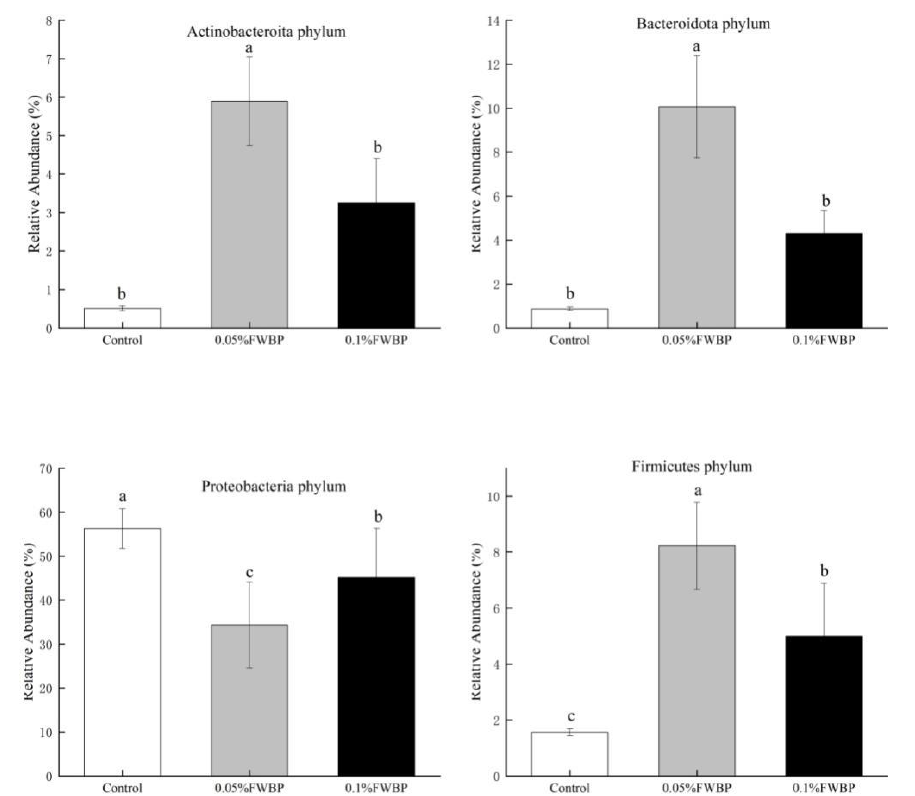
Figure 8. Microbial community in zebrafish fed with FWBP, at the phylum level. FWBP: Fermented wheat bran polysaccharides. Different lowercase superscript letters denote statistically significant differences among different groups ( p < 0.05).